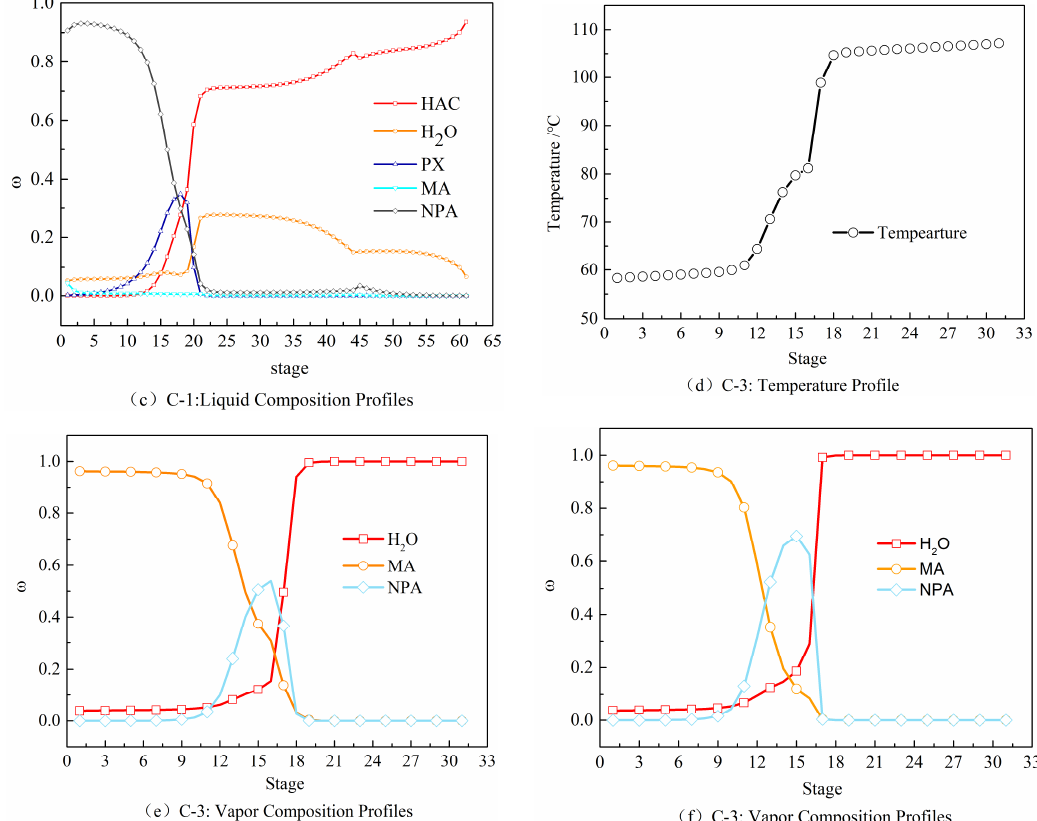
Figure 2. Temperature and composition distribution during the steady-state of C-1 and C-3.